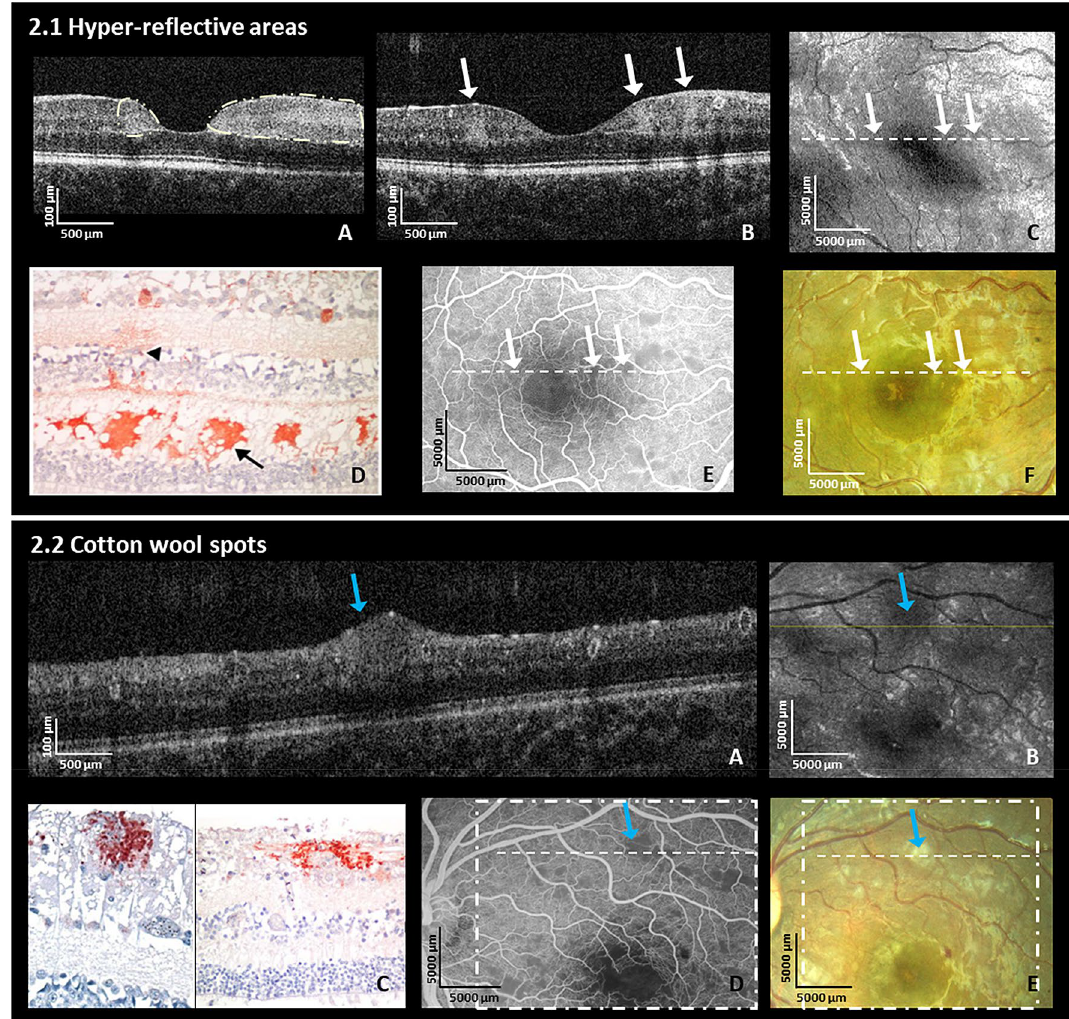
Figure 2. Hyper-reflective areas and cotton wool spots (Retinal Whitening). ( 2.1.A, B ) shows multiple hyper- reflective areas of various sizes (white arrows) located in the inner nuclear layer level, the outer plexiform layer and outer nuclear layer on OCT B-scans in the right eye of a 22-month old male CM patient and in the left eye of an 84-month old female CM patient at admission, respectively; ( C ) En-face OCT of the patient in ( B ); white arrows correspond to the location of white arrows in the image ( B ) (hyper-reflective areas); The hyper- reflective areas in OCT B-scan ( B ) show darkening on the en-face image ( C ) in this patient (white arrows); ( D ) Representative histology of immuno-histochemical staining for fibrinogen surrounding a small vessel (black arrowhead) mainly located in OPL (black arrow) from the literature (Reprinted with permission) 17 . ( E ) Fundus fluorescein angiography showing hypo-perfusion of capillaries and ( F ) fundus photo same eye as OCT in ( B ); white arrows and dashed lines show parafoveal whitening which are corresponding to the same fundus locations in ( B, C, E, F ). ( 2.2.A ) Cotton wool spot (blue arrow) in the left eye at admission on OCT B-scan in the left eye of a 42-months old male CM patient at admission; ( B ) En-face OCT with darkening in area of cotton wool spot (blue arrow); fine yellow line: location of the B-scan in the image ( A ); blue arrow corresponds to blue arrow in image ( A ); ( C ) Immunohistochemical staining for b-APP in retinal nerve fiber layer (RNFL) from different CM patients. Reprinted with permission 17 . ( D ) Fundus fluorescein angiography showing grey area masking underlying capillaries (blue arrow) and ( E ) fundus photo from patient’s left eye corresponding to OCT showing white cotton wool spot (blue arrow) in ( 2.2.A ). The dashed square and the dashed line correspond to en-face OCT in B and B-scan in ( A ). Blue arrows show the location of a cotton wool spot. Blue arrows correspond to the same fundus locations in ( A, B, D, E